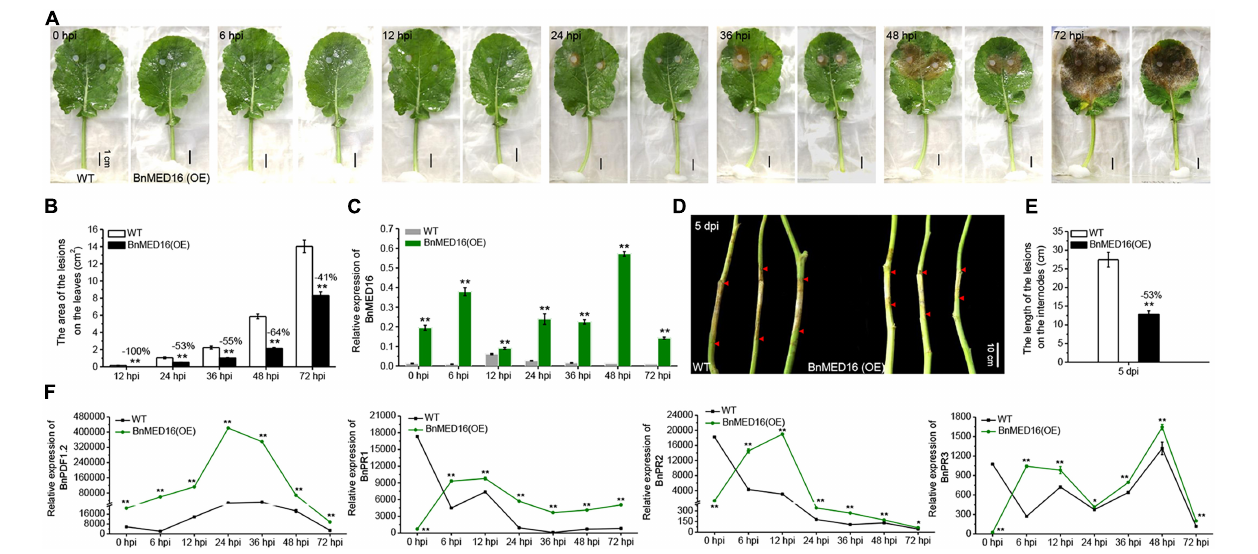
FIGURE 2 | Overexpression of BnMED16 conferred resistance to S. sclerotiorum in transgenic rapeseed plants. (A) T4 homozygous BnMED16(OE) lines and WT inoculated with 6 mm diameter agar plugs of S. sclerotiorum hyphae at 22 ◦ C. Images were taken at 0, 6, 12, 24, 36, 48, and 72 hpi. BnMED16(OE) was the transgenic plants that overexpressed BnMED16 genes in B. napus . Bars, 1 cm. (B) Lesion areas in BnMED16(OE) and WT leaves at different time points after inoculation as shown in (A) . (C) Expression pattern of BnMED16 in BnMED16(OE) and WT leaves at different time points after inoculation as shown in (A) . Data are means ( ± SD) of three biological replicates. (D) Images of BnMED16(OE) and WT stem inoculated with S. sclerotiorum after 5 days. dpi, days post-inoculation. Bars, 10 cm. (E) Lesion lengths in BnMED16(OE) and WT stem after inoculation as shown in (D) . (F) Expression pattern of BnPDF1.2 ( BnaC02g23620D ), BnPR1 ( BnaC01g04530D ), BnPR2 ( BnaA01g17540D ), and BnPR3 ( BnaA05g26640D ) in BnMED16(OE) and WT leaves at different time points after inoculation as shown in (A) . BnActin7 was used as the internal control. The data are the mean ± SD of three independent biological replicates; n ≥ 10 leaves (B) and n = 10 stems (E) were measured in each replicate and the asterisks denote statistical significance at P < 0.01 (**) or P < 0.05 (*) between the WT and BnMED16(OE) lines at each time point by Student’s t -tests. Percentage changes relative to the WT are